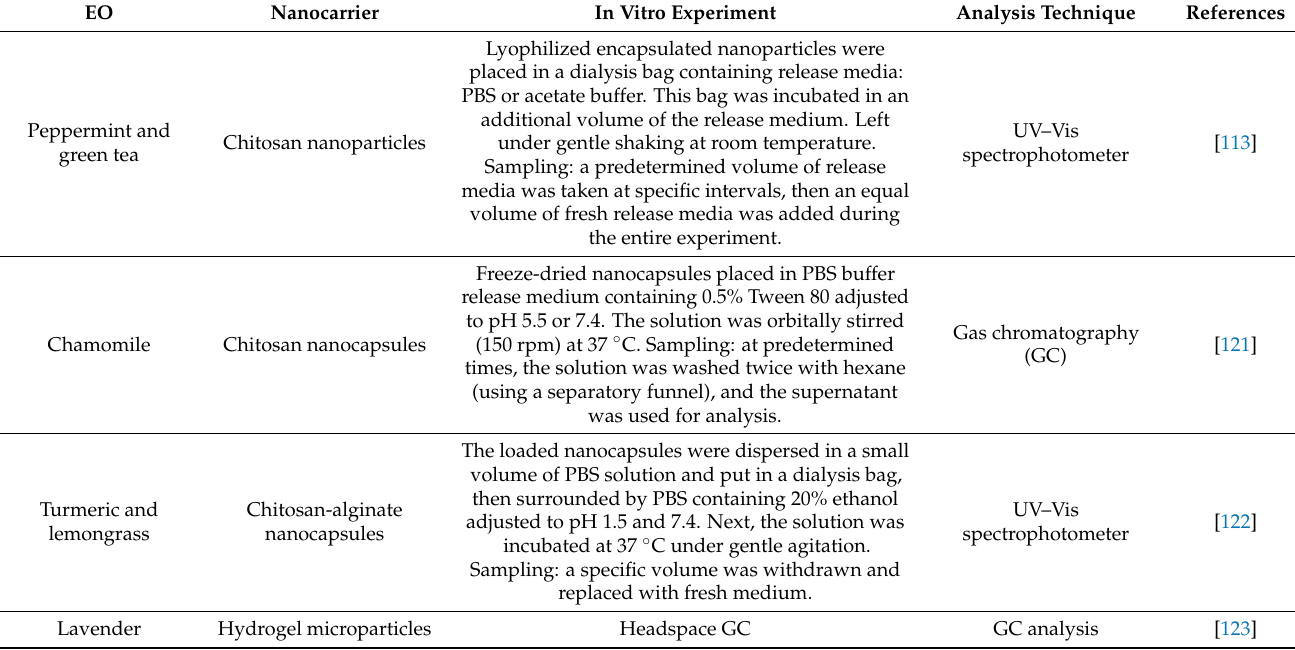
Table 2. Experimental in vitro release and analysis techniques of EOs from nanoformulations of different